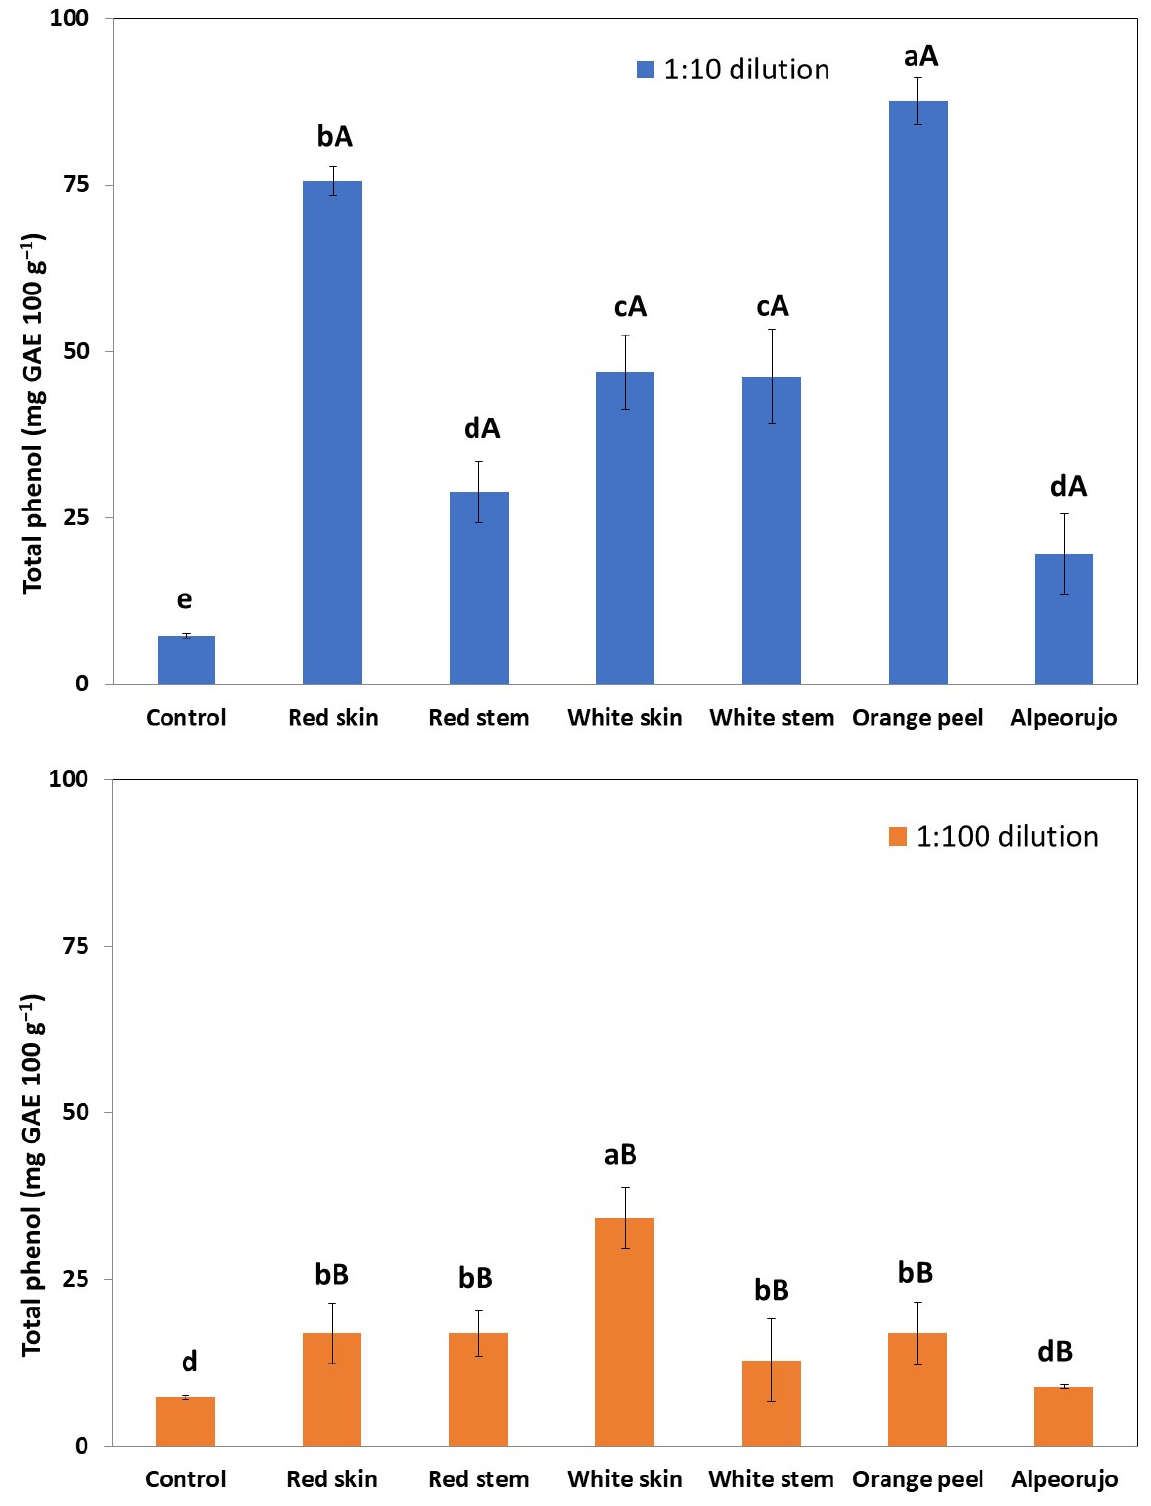
Figure 2. Total phenol (mg GAE 100 g − 1 ) of ‘Manzanilla Cacereña’ table olive variety after the addition of different agro-industrial by-products. Different lowercase letters mean a statistically significant difference between by-product extracts (Tukey’s test p < 0.05 n = 3). Different capital letters mean significant differences between the different dilutions (Tukey’s test p < 0.05 n = 3).